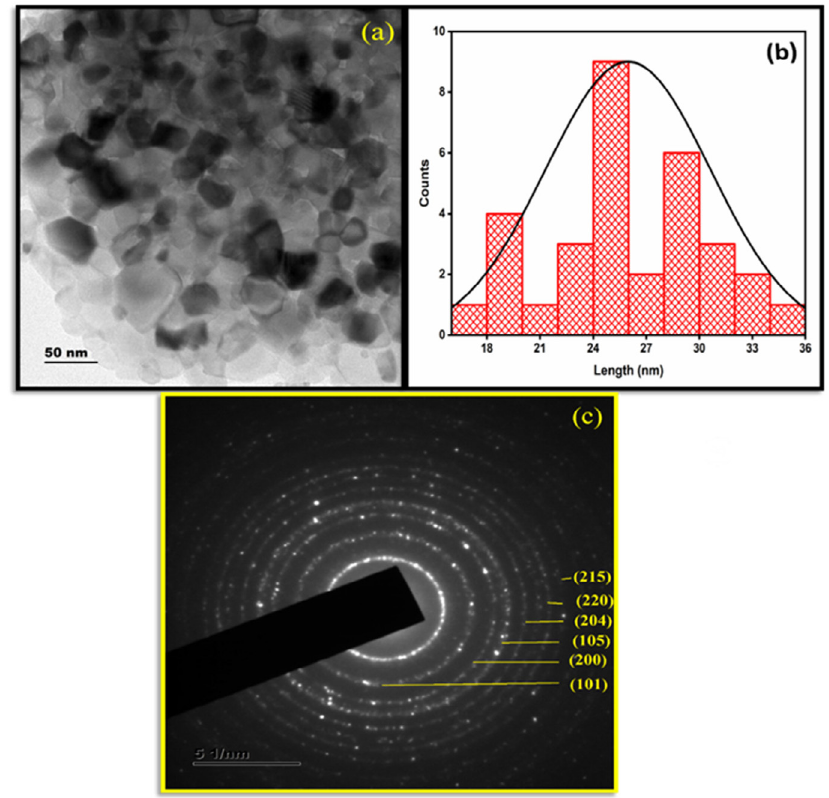
Fig. 3. (a) HRTEM image of TiO